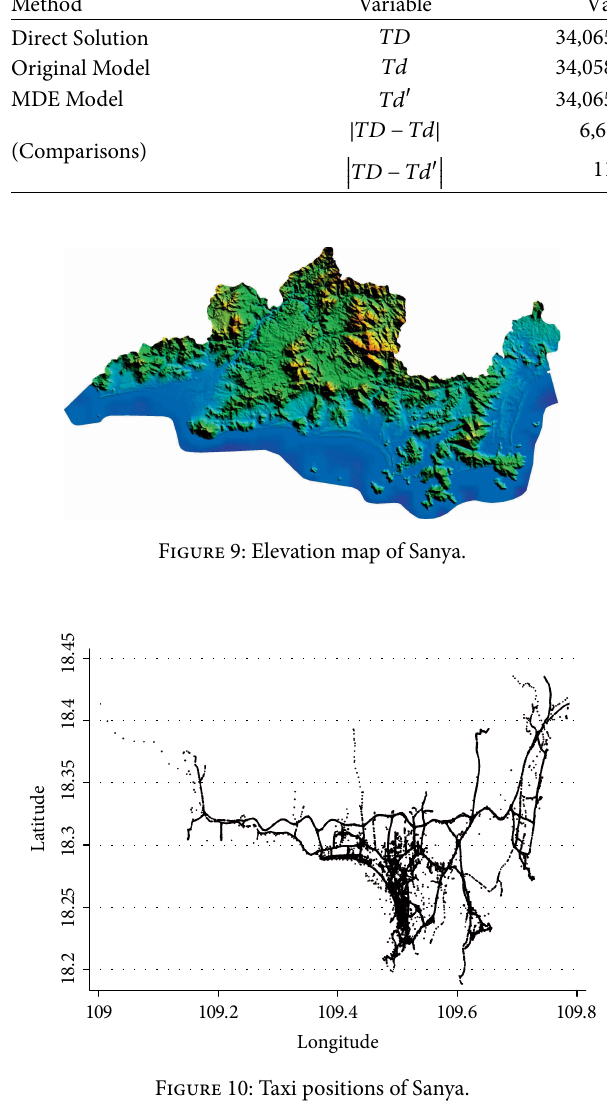
Figure 10: Taxi positions of